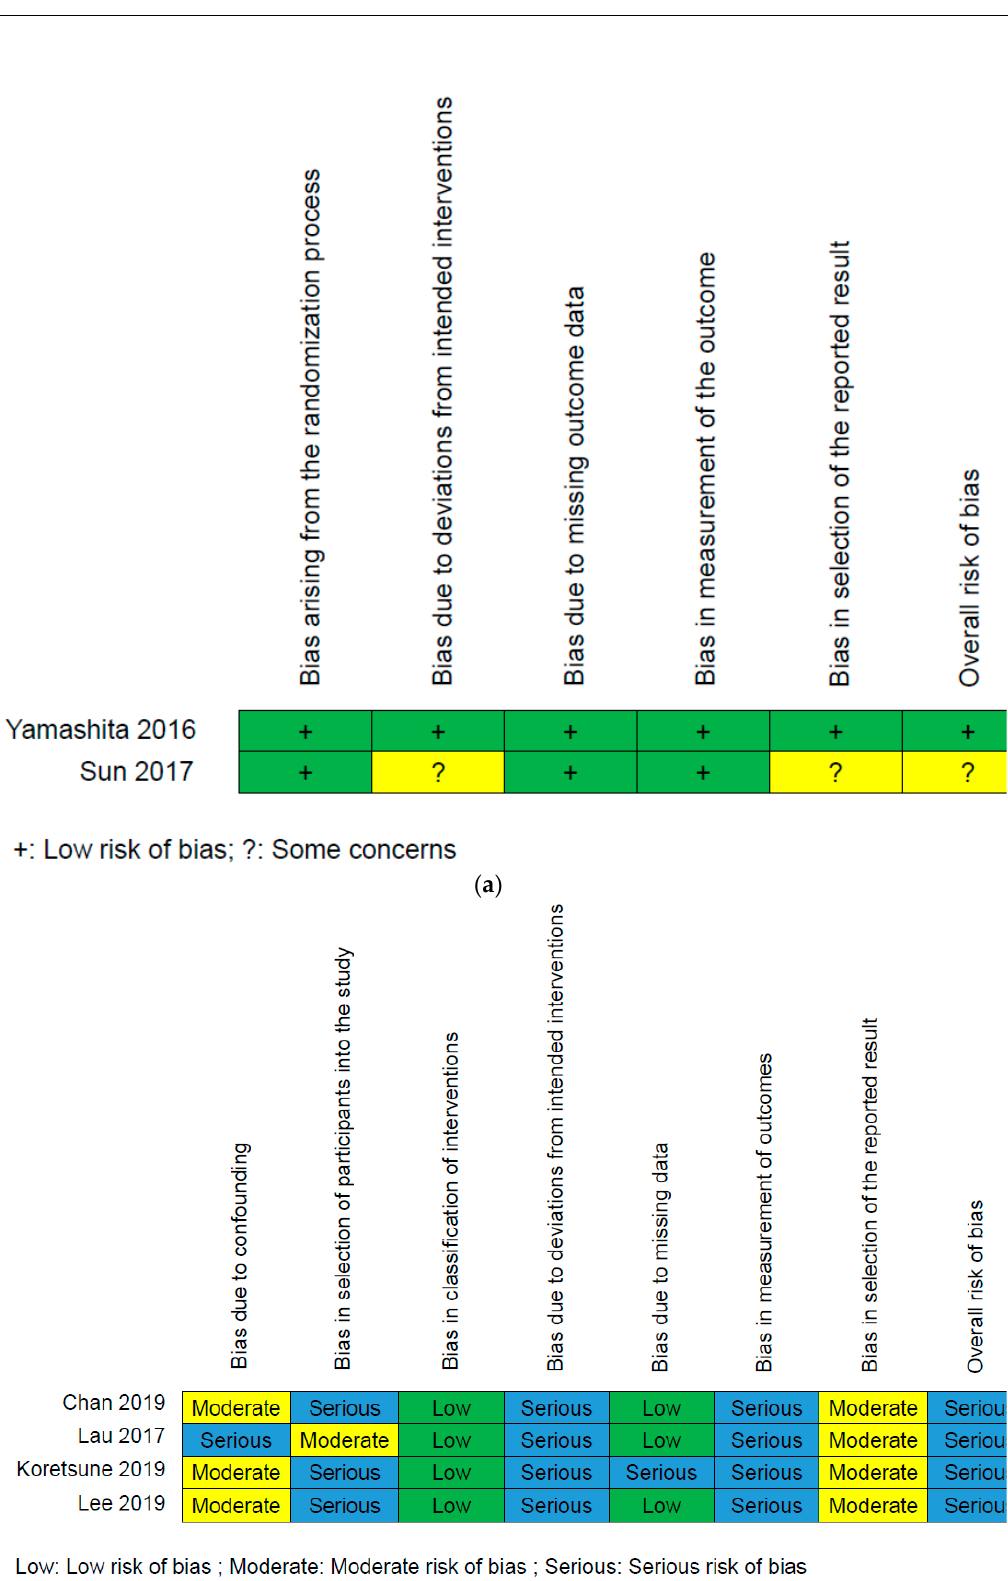
Figure 2. ( a ) Summary of each randomized controlled trial (RCT) appraised by ROB 2.0. ( b ) Summary of each retrospective study evaluated by ROBINS-I.